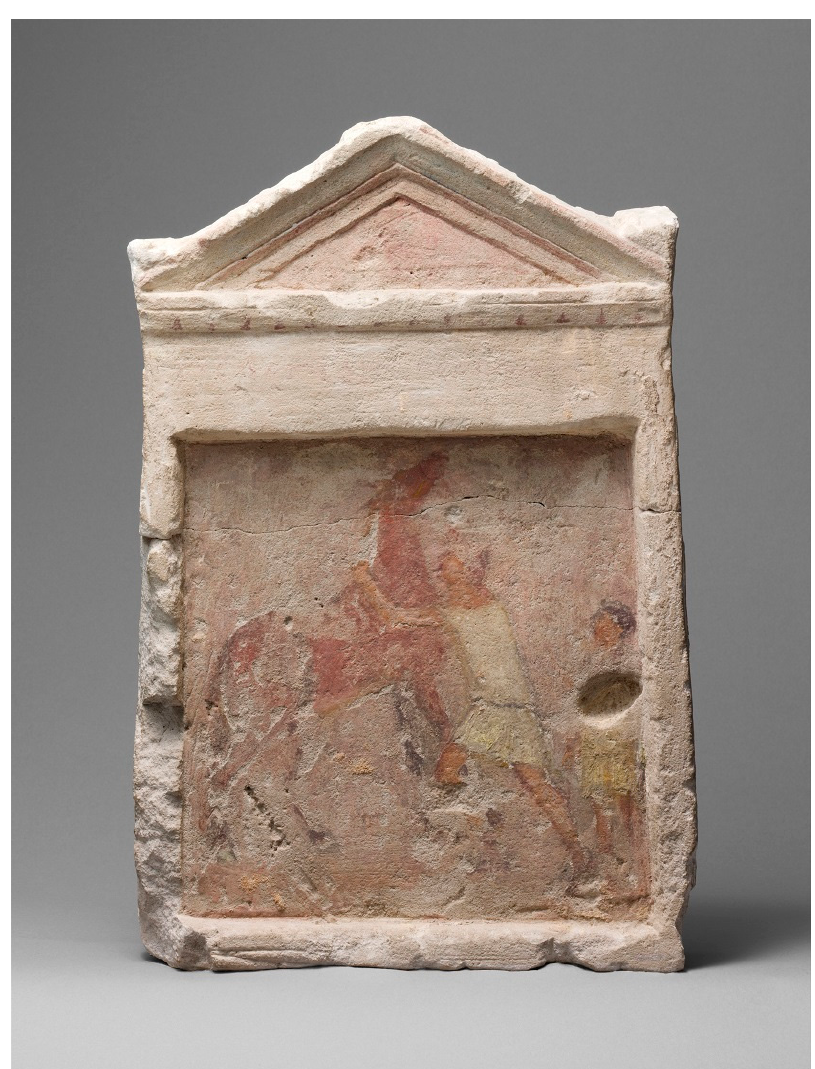
Figure 1. Painted Limestone Funerary Slab with a Man Controlling a Rearing Horse. © The Figure1. PaintedLimestoneFunerarySlabwithaManControllingaRearingHorse. © TheMetropolitan Metropolitan Museum of Art. Museum of